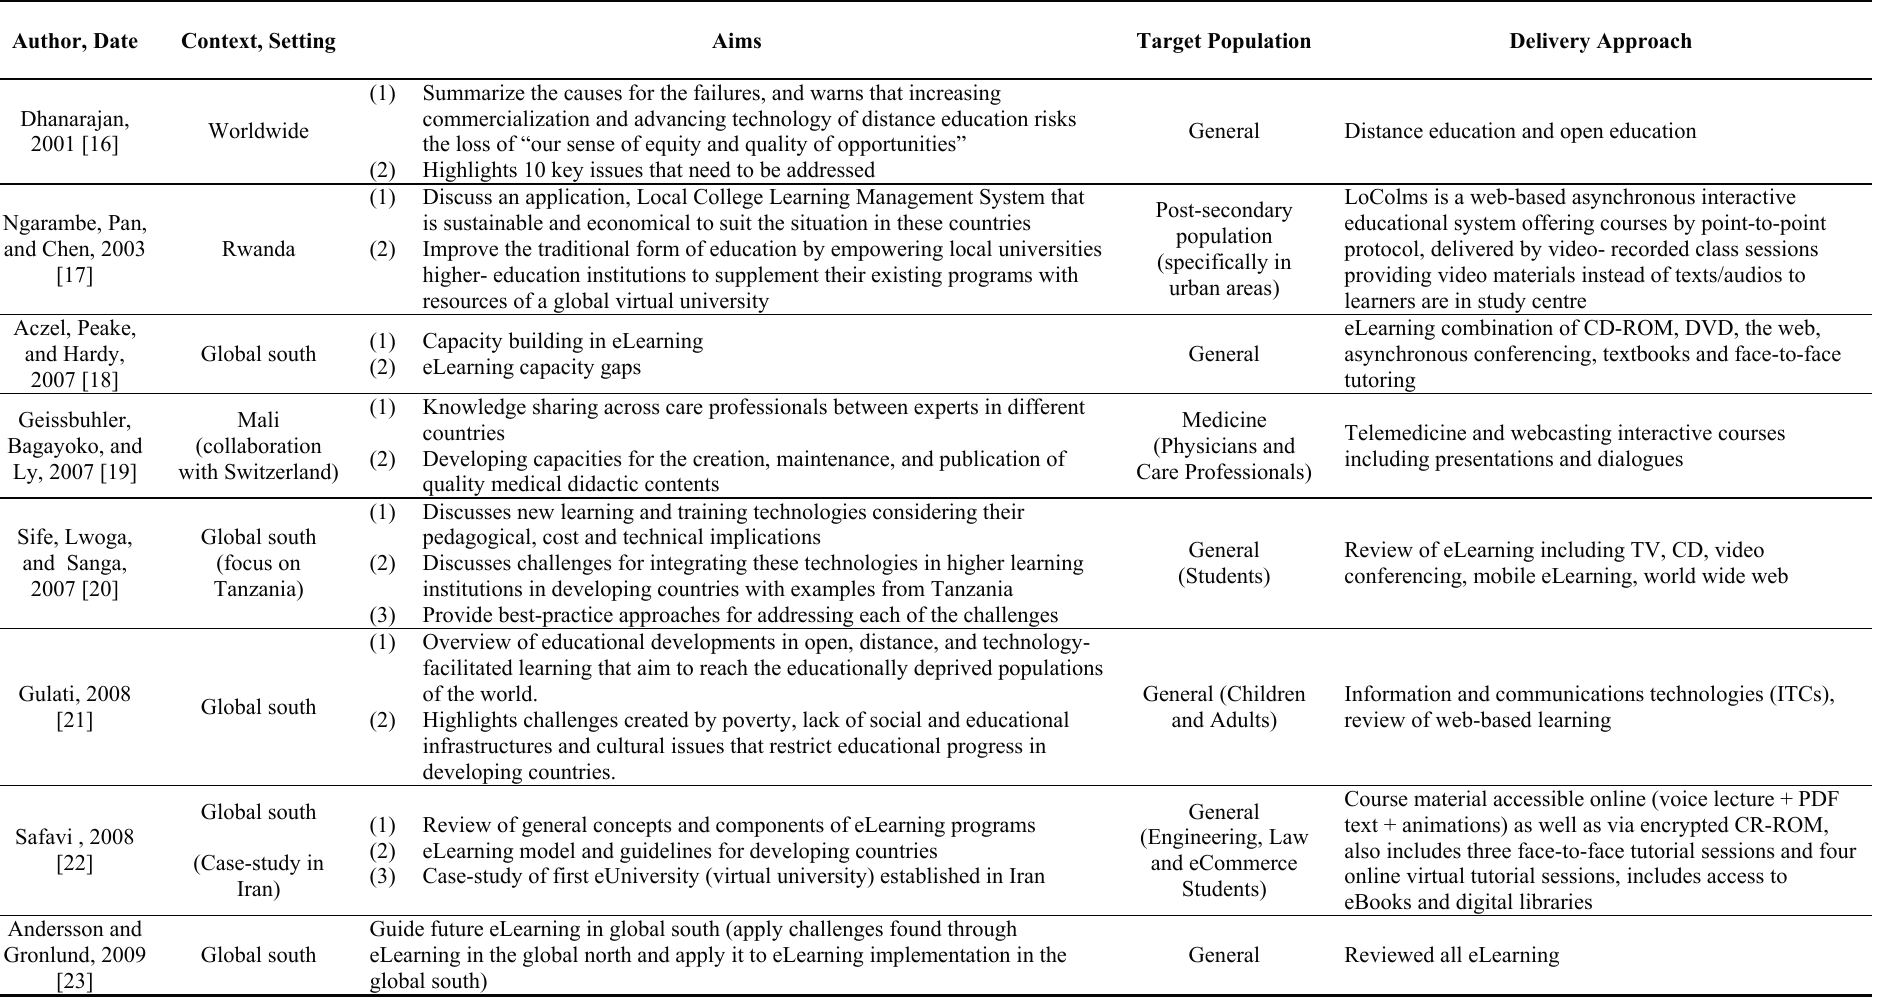
Table 1. Summary of findings from 13 peer-reviewed review studies of eLearning in developing